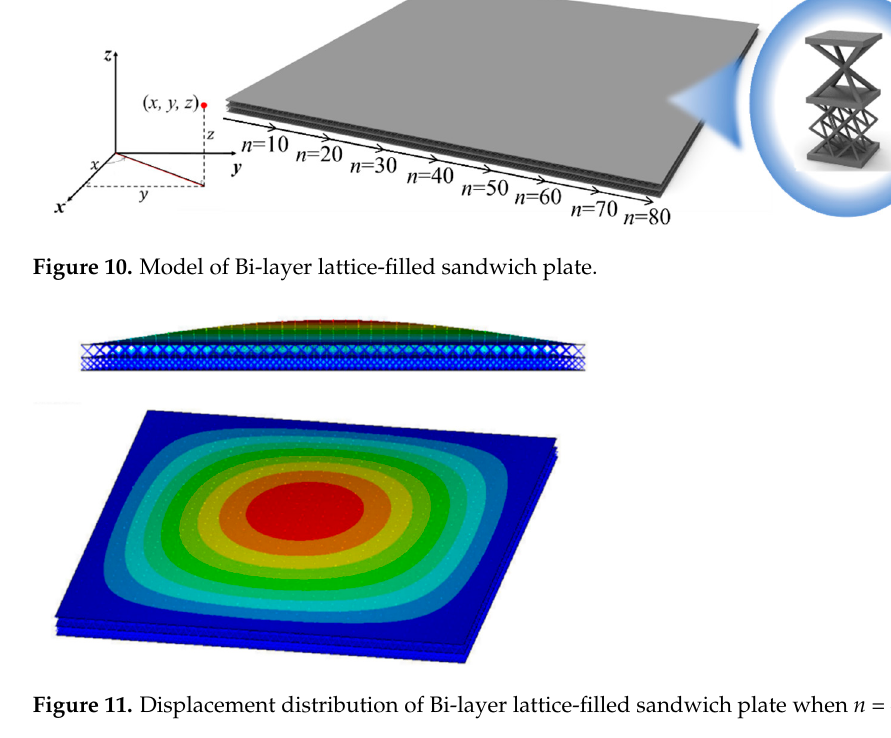
Figure 11. Displacement distribution of Bi-layer lattice-filled sandwich plate when n = 40.